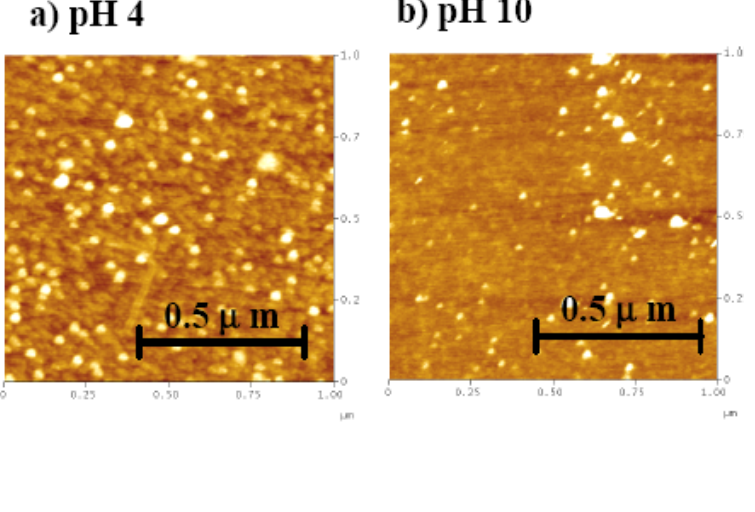
conjugated on the surface of 20 nm gold colloid on Figure 8. The AFM images of A  1-40 the surface of mica. The condition of deposited solution was (a) pH 4 and (b) pH 10.